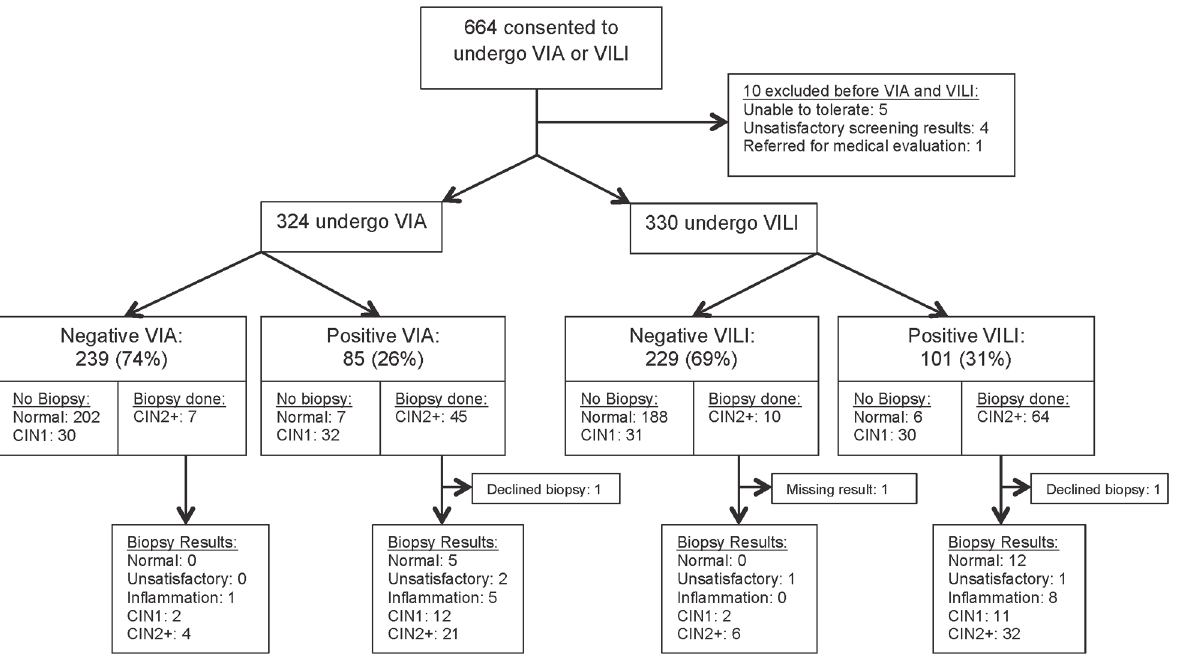
Fig 1. Flowsheet of enrollment, randomization and screening results for VIA and